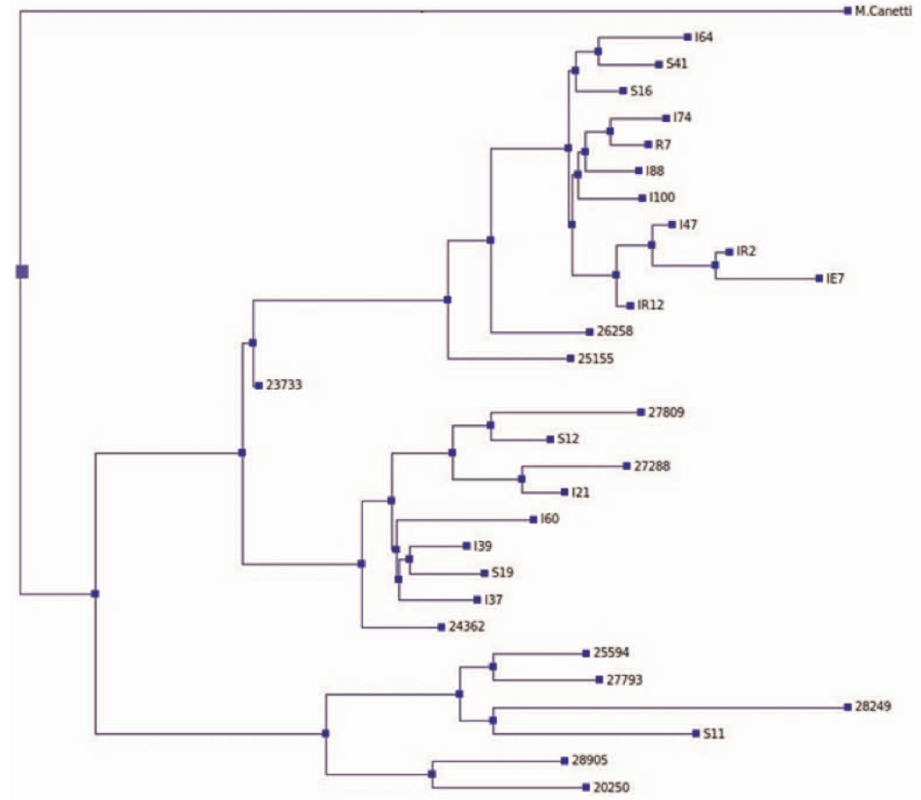
Figure 1. Phylogenetic tree of 29 Mycobacterium tuberculosis isolates. The whole genome sequences of the 29 isolates were used to construct the tree, with Mycobacterium canetti used as an outlier, in order to identify and eliminate mutations that were phylogenetically related. Drug-resistant isolates were coded according to the drugs they were resistant to: isolates resistant to isoniazid were coded with ‘‘I’’; those resistant to rifampicin, ‘‘R’’; those resistant to streptomycin, ‘‘S’’; those resistant to ethambutol, ‘‘E’’. All isolates coded with 5-digit numbers (2XXXX), were INH- susceptible isolates. Spoligotyping assigned the isolates into these lineages: I64, S41, S16, I74, R7, I88, I100, I47, IR2, IE7 and IR12 belonged to the Beijing lineage; 26258, 25155, 23733, I37 and 27793, the U lineage; 27809, 27288, I21, I39, S19, 24362, 25594 and 28249, the T lineage; S12, the Haarlem lineage; I60, the LAM lineage; 28905, the H37Rv lineage; and the isolates S11 and 20250, the EAI lineage.